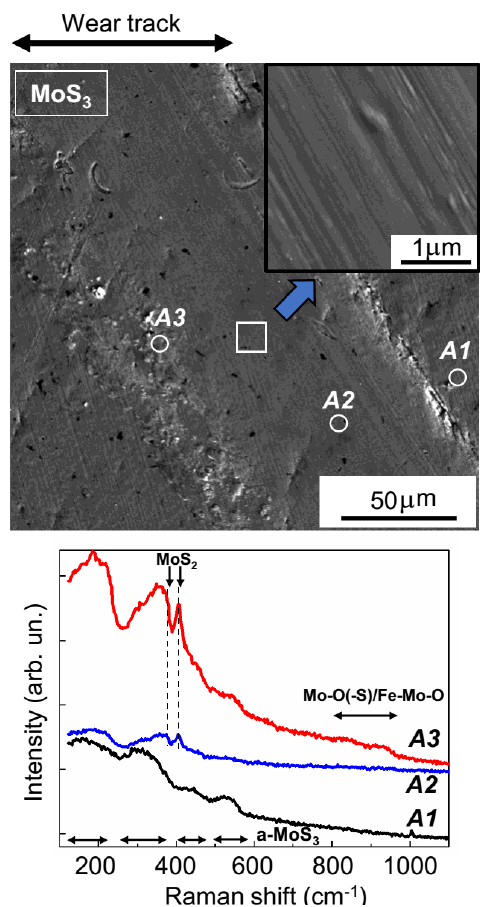
Figure 9. SEM image and Raman spectra of MoS 3 coatings subjected to tribo-testing at −100 °C in the argon–air mixture (RH ~ 9%). Raman spectra were measured on the unworn surface of the coating (area A1 ), in the center of the wear track (areas A2 ), and at the track boundary, which contained adhered wear debris (area A3 ).